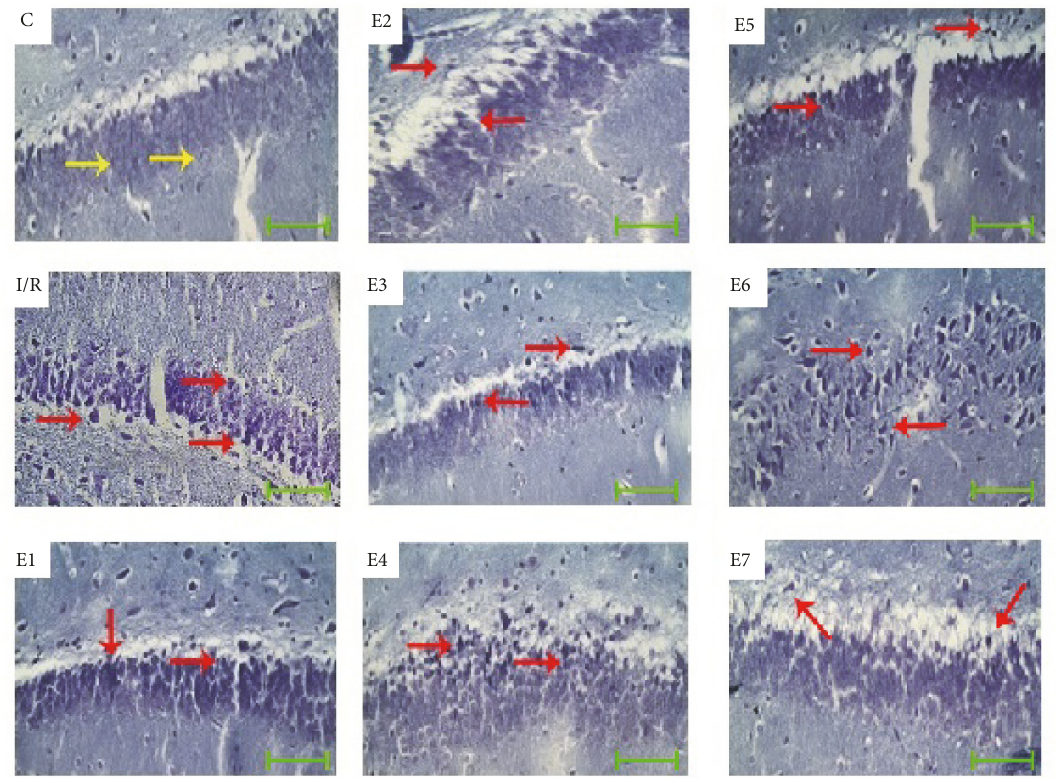
Figure1:Photomicrographsofcoronalsectionsofthehippocampus(dentategyrusarea)showedthatinthecontrolgroup(C),pyramidalcells (yellow arrows) showed normal morphology. In the I/R group, ischemia induces shrinkage, apoptotic, and fragmented neurons (Nissl bodies, red arrows). However, administered FK506 could significantly reduce Nissl bodies in E1-E5 groups (Nissl staining, 400 × magnification, scale bar= 50 𝜇